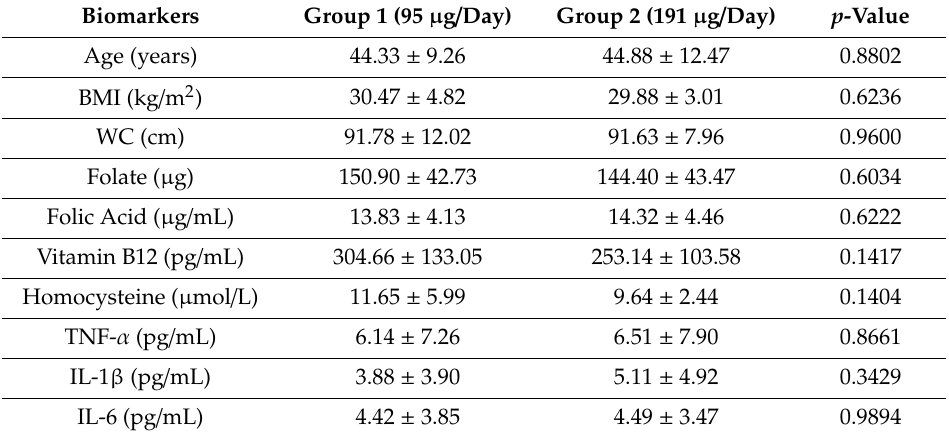
Table 3. General characteristics of the participants by groups before the feeding